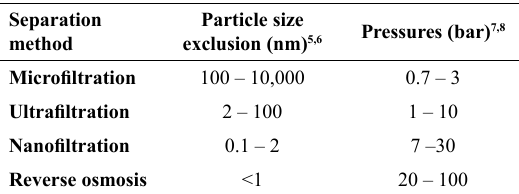
Table 1. Typical values of pore size and pressures used on membrane separation